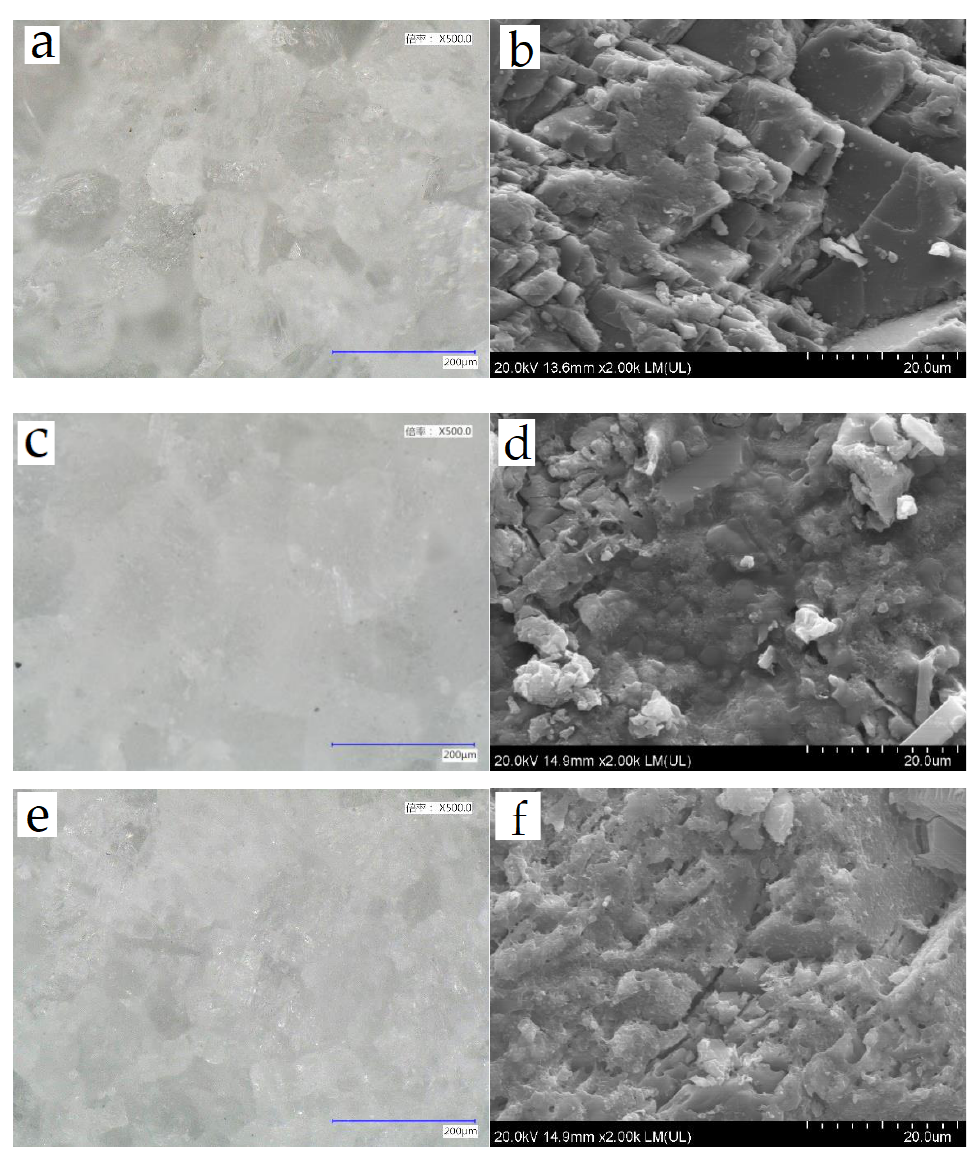
Figure 2. Optical images ( 倍率 = magnification) and FESEM results of specimens’ surface: ( a ) Microscope image of DM surface; ( b ) FESEM micrograph of DM surface; ( c ) Microscope image of H1 surface; ( d ) FESEM micrograph of H1 surface; ( e ) Microscope image of H2 surface; ( f ) FESEM micrograph of H2 surface.